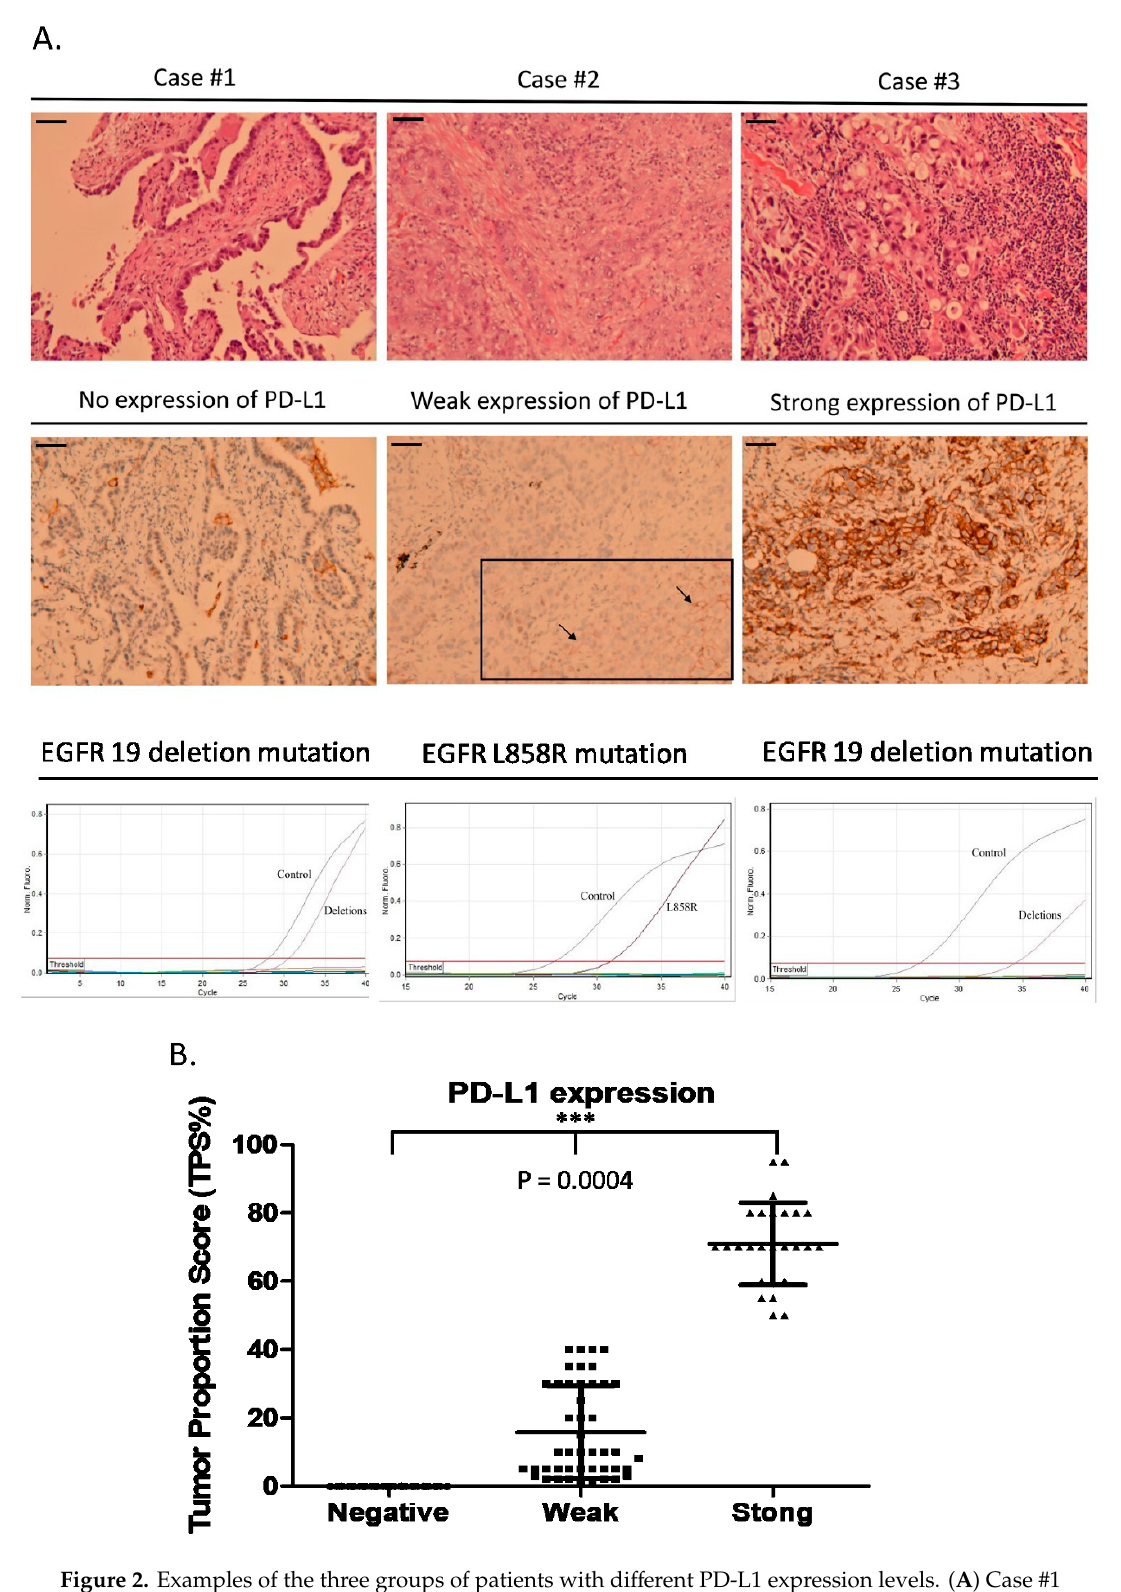
Figure 2. Examples of the three groups of patients with different PD-L1 expression levels. ( A ) Case #1 EGFR exon 19 deletion mutation without PD-L1 expression; case #2 EGFR L858R mutation with weak PD-L1 expression; case #3 EGFR exon 19 deletion with strong PD-L1 expression. ( B ) Comparison of PD-L1 expression levels among the three groups (mean ± SD %) (0 versus 15.8 ± 13.2 versus 70.9 ± 12, p = 0.0004). The scale bar = 100 µ m.